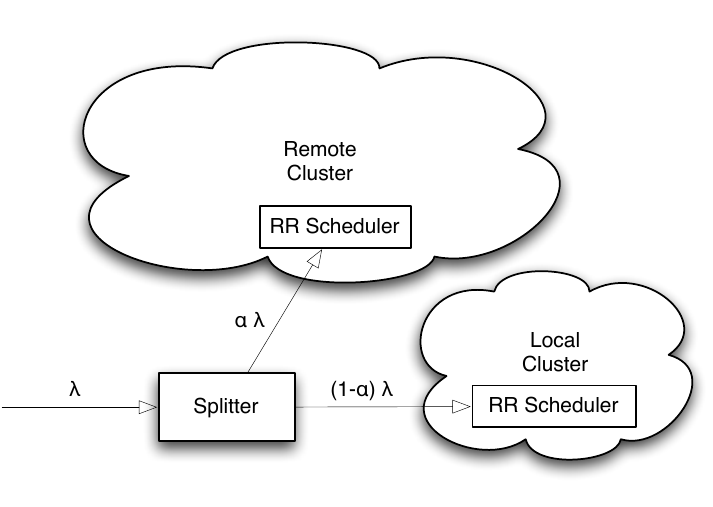
Figure 1. Experimental